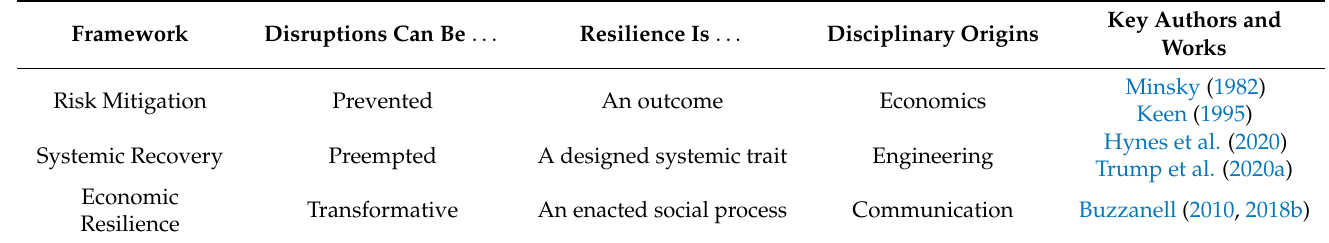
Table 1. Summary of